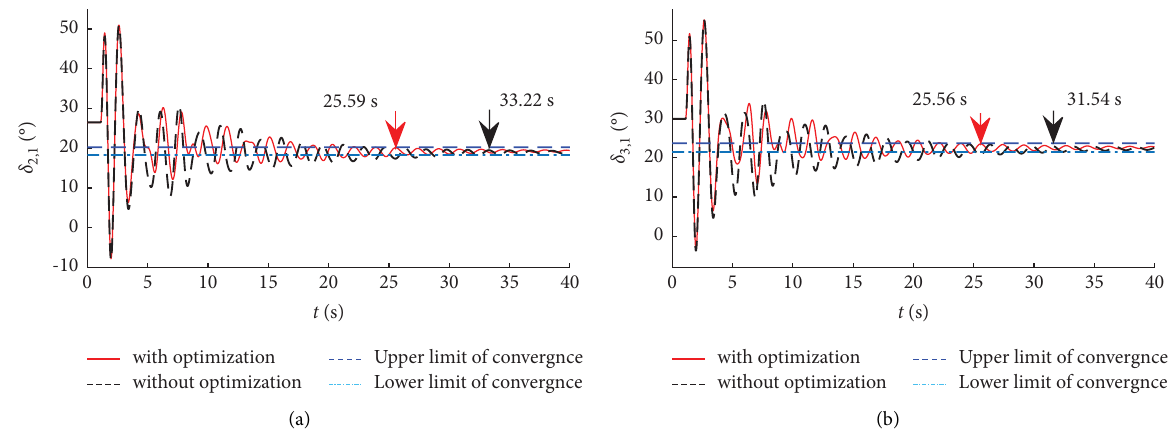
A , K F , T F , V ref , and I DC,ref . (a) Power angle